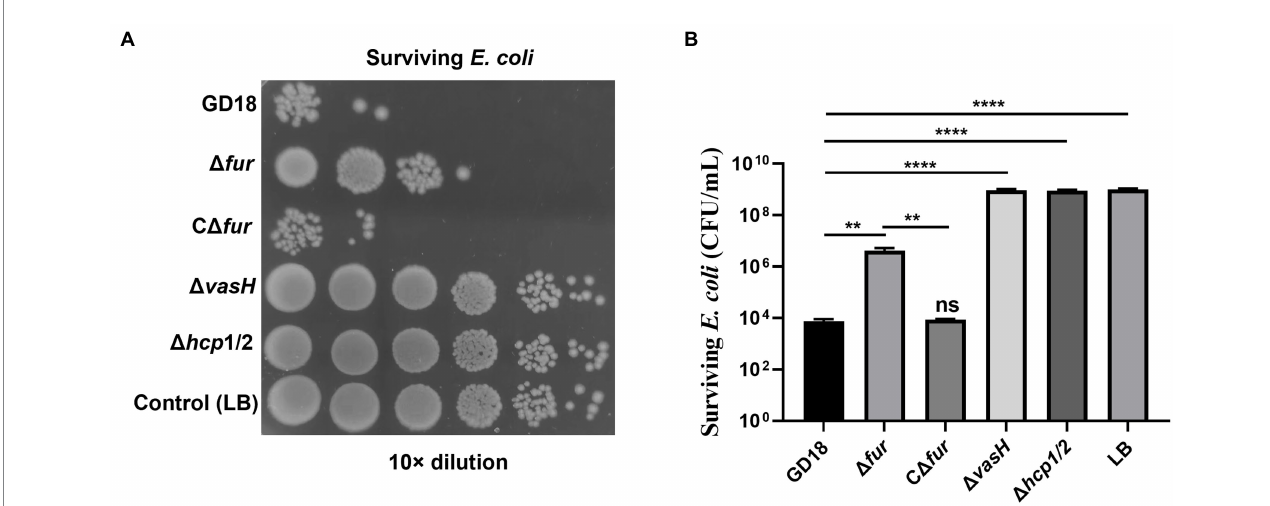
FIGURE 4 Fur facilitates the interbacterial competition of A. hydrophila in vitro . The survival of Escherichia coli was determined by detecting CFUs post incubation with different A. hydrophila strains as indicated. The fresh attacker ( A. hydrophila ) and prey ( E. coli DH5 α ) were combined at a 1:5 ratio in LB plates with nitrocellulose membranes for 3 h at 28 ° C. (A) The surviving E. coli cells were serially diluted and determined on the LB plate containing kanamycin. Control (LB) indicates incubation of E. coli with sterile LB medium alone. Δ hcp 1/2 mutant group was set as the T6SS defective control group. (B) The prey strain’s survival rate was then determined. The error bars represent mean ± standard deviations from three independent experiments (** p < 0.01; **** p < 0.0001).